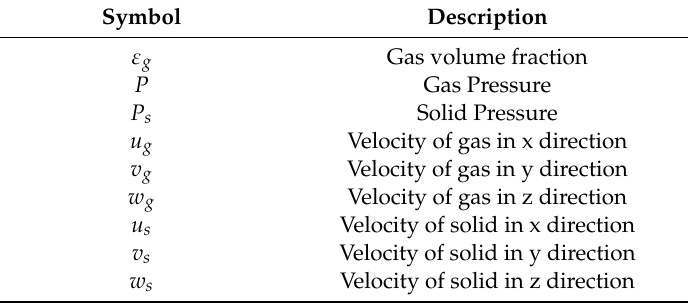
Table 2. Multiphase Flow with Interphase eXchanges (MFiX) output variables used in artificial neural network (ANN) training.